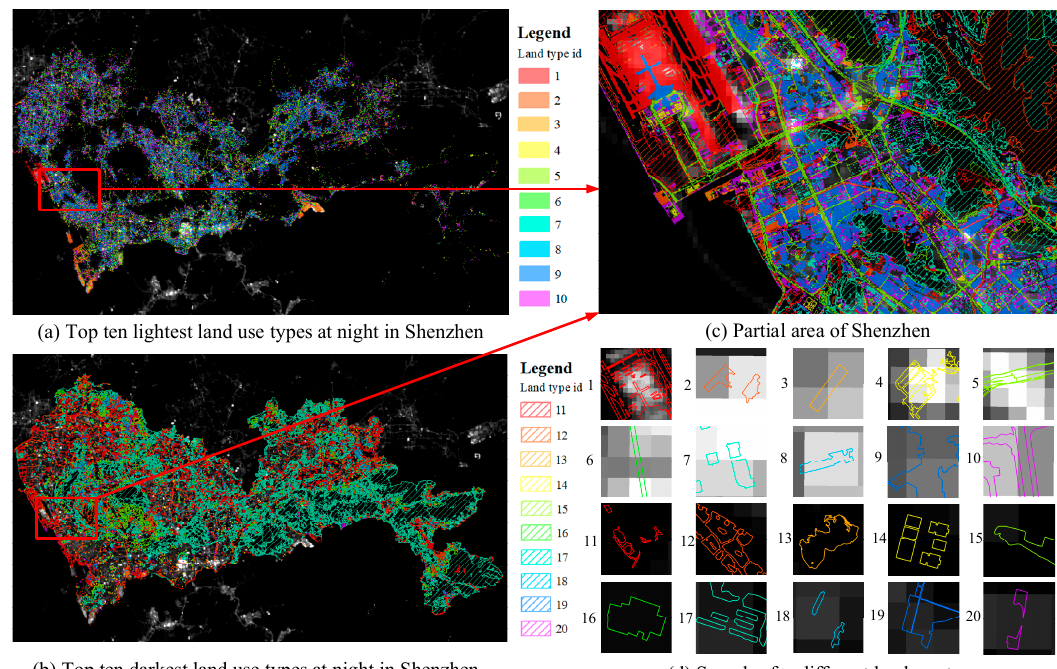
Figure A2. Top ten lightest and darkest land use types at night in Shenzhen.